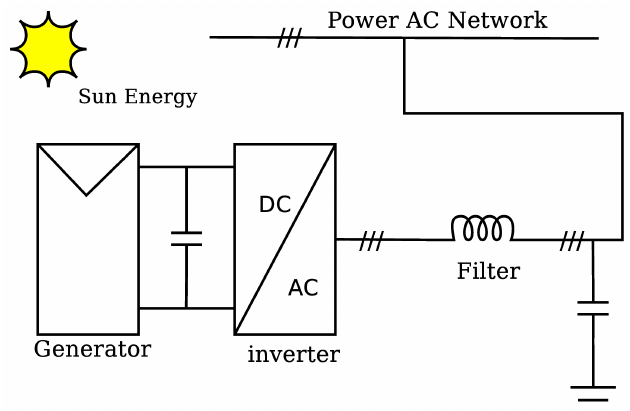
Figure 1. Scheme of the plant under